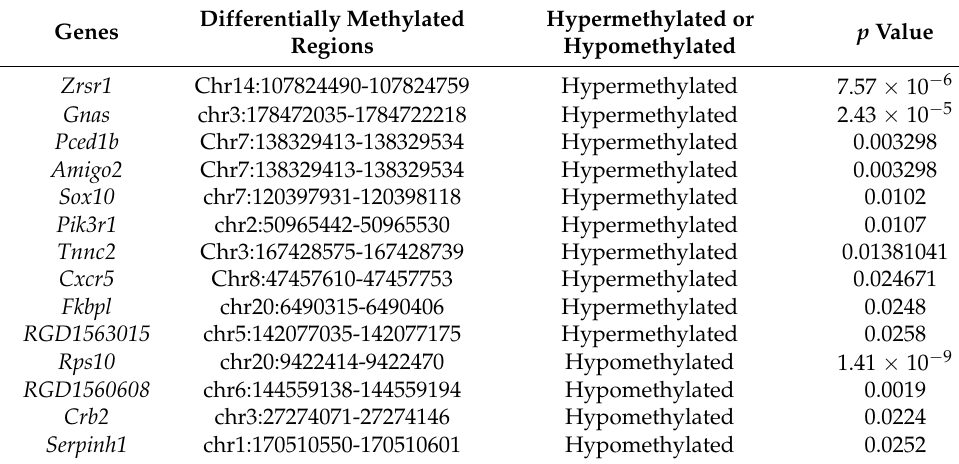
Table 2. Genes with differentially methylated regions (DMRs) in their promoter region.